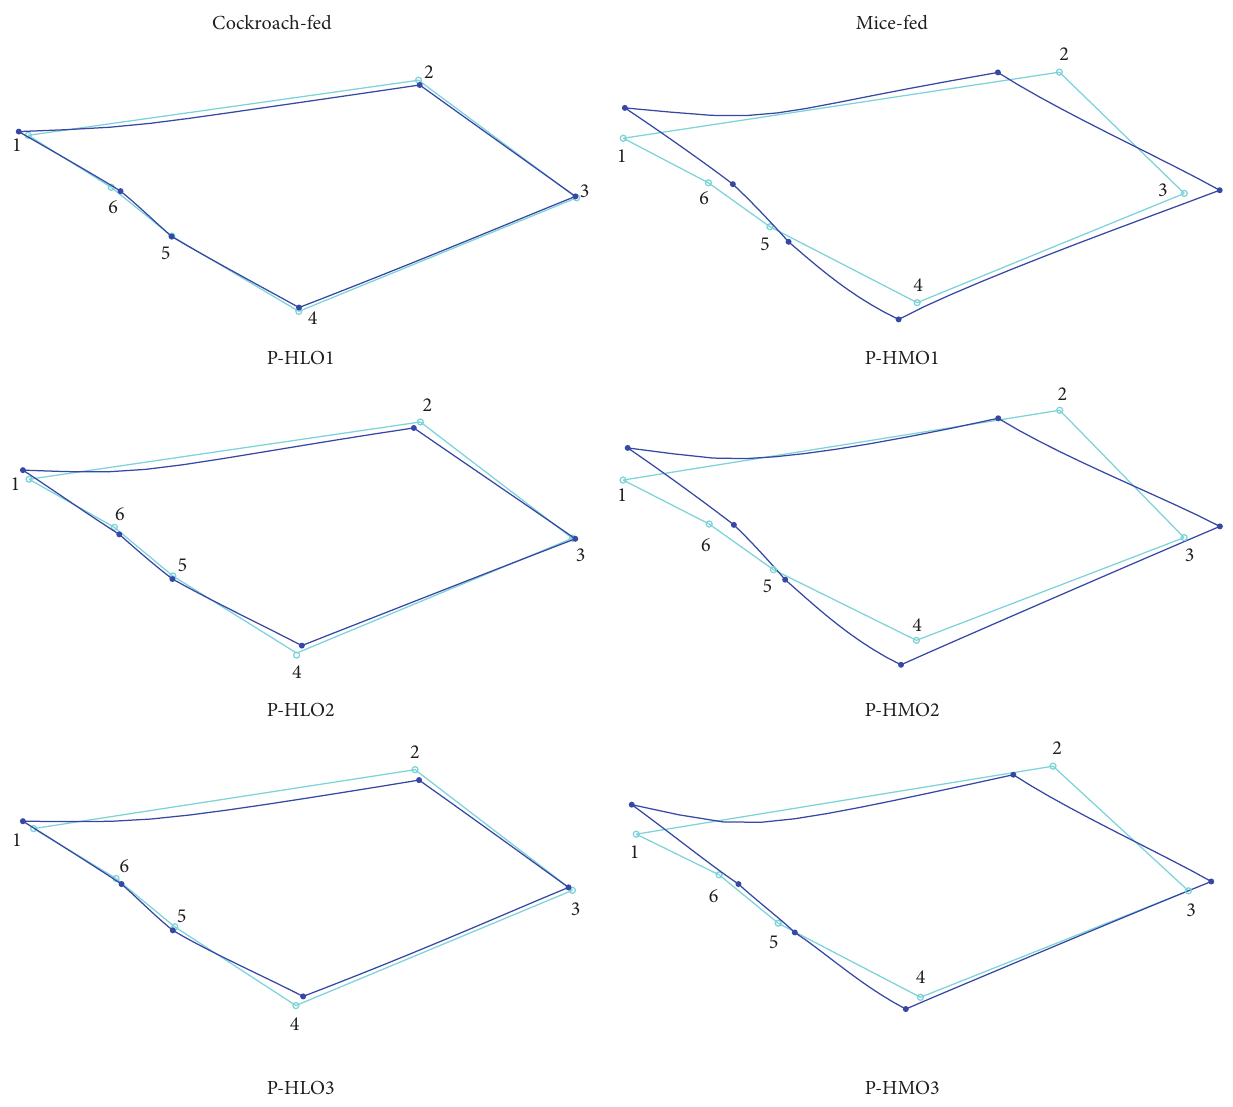
Figure 5: Wing deformation caused by superimposing the offspring shape on the parental shape. The sky blue configuration refers to the average shape of the parental males and the dark blue one to the deformation of the parental shape introduced by the laboratory-bred males. Points 1 through 6 refer to the landmark used to define the wing configuration. (P) Parental, HL (hemolymphagy = fed on cockroaches), HM (hematophagy = fed on mice), O1 (first offspring), O2 (second offspring), and O3 (third offspring).